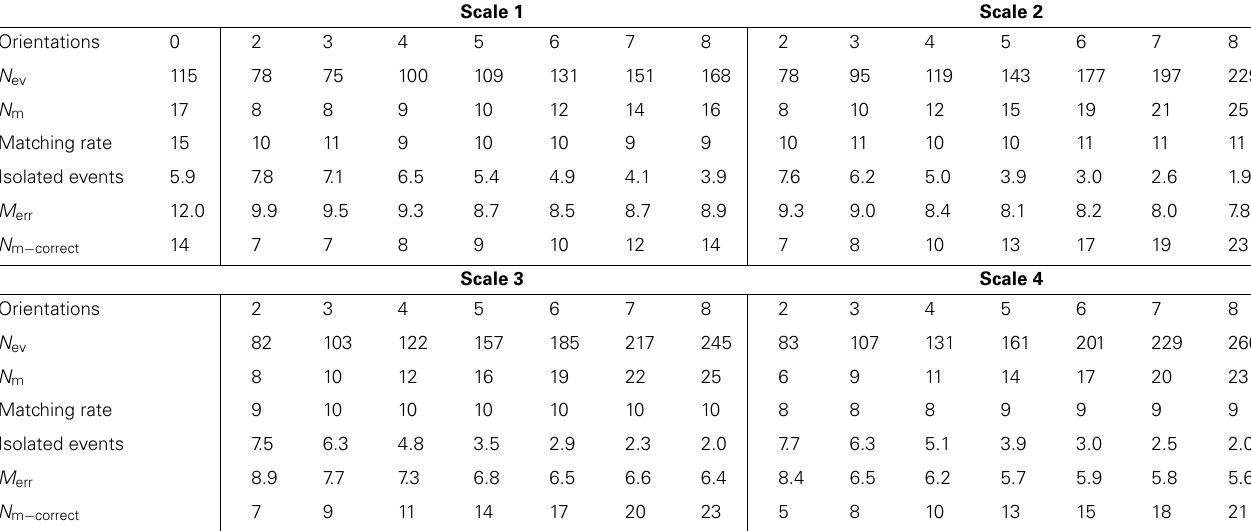
Table 2 | Comparison of the 3D reconstruction results for the ring.